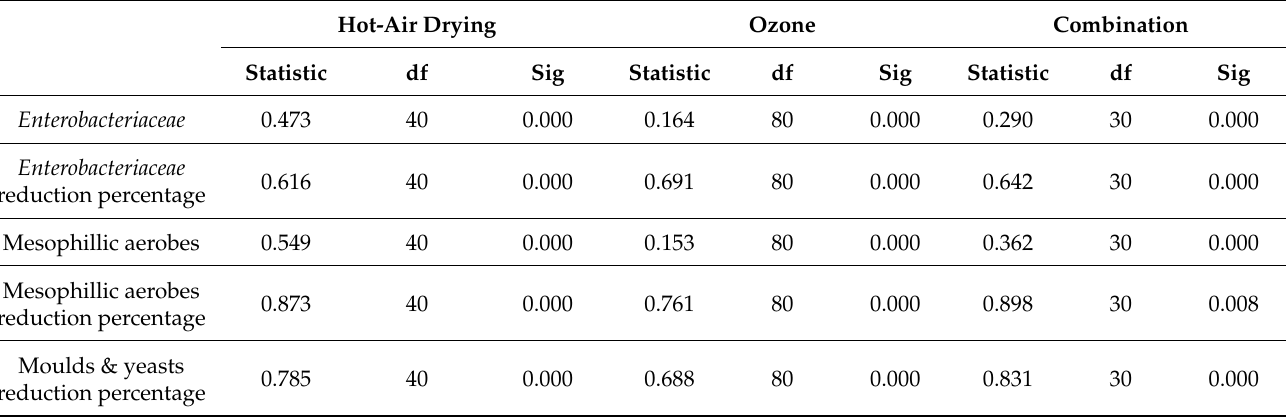
Table 1. Shapiro–Wilk test for the study and distribution of the data, p <